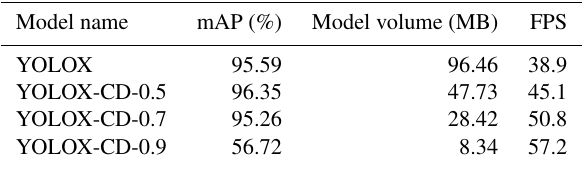
Table 3. Model performance comparison with different pruning rates.